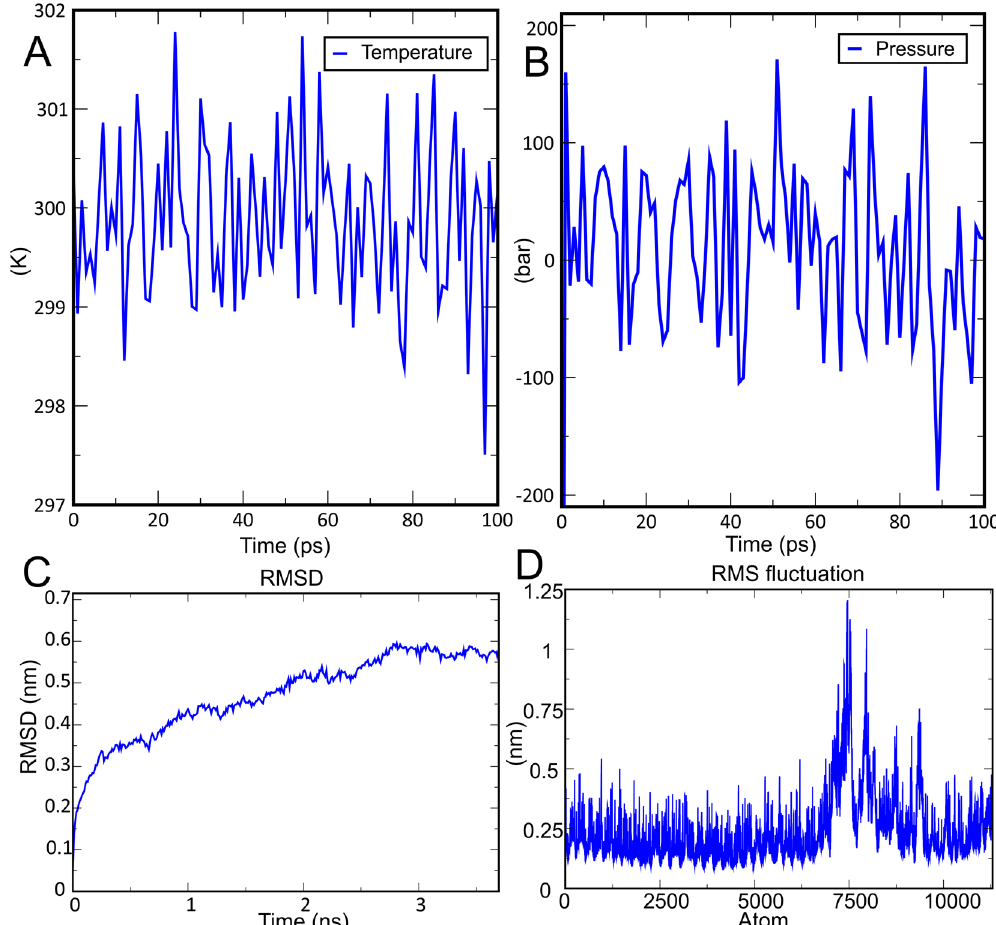
Figure 6. Molecular dynamics simulation of the ligand-receptor complex (vaccine & TLR-3) ( A ) Temperature progression plot of ligand-receptor complex shows that temperature of the system reaches to 300K and remains nearly constant around 300K throughout equilibration phase (100 ps). ( B ) Ligand-receptor complex pressure progression plot indicates fluctuation of pressure throughout the equilibration phase of 100 ps with an average pressure value 1 bar. ( C ) RMSD-Root Mean Square Deviation of docked complex shows very minute deviation which reflects the stable microscopic interaction between ligand and receptor molecule. ( D ) RMSF-Root Mean Square Fluctuation plot of docked protein complex side chain fluctuation in plot generates peak which reflects the flexibility of side chain of docked protein